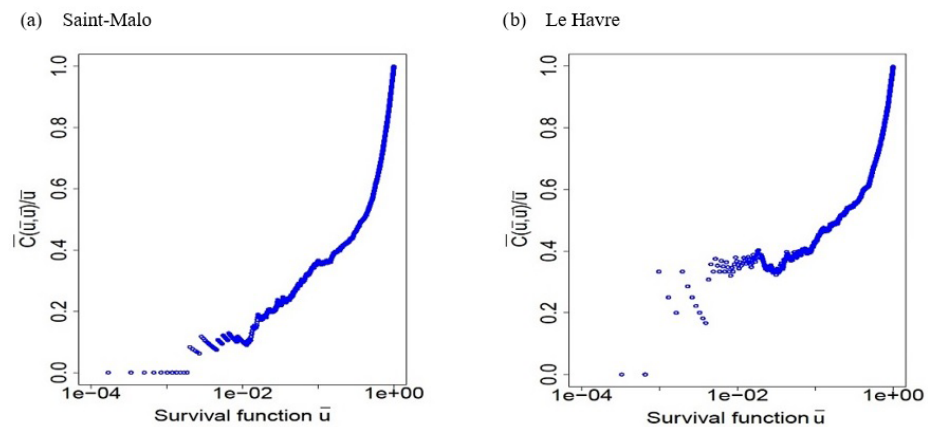
Figure 4. C(u,u) for (a) Saint-Malo and (b) Le Havre samples. u